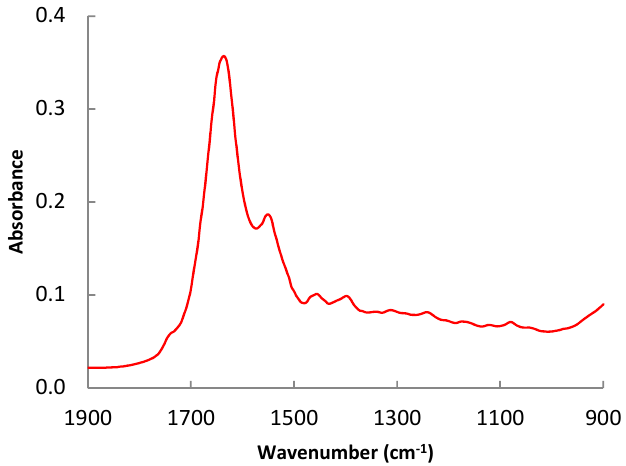
Figure 2. Representative spectrum of the samples analyzed.